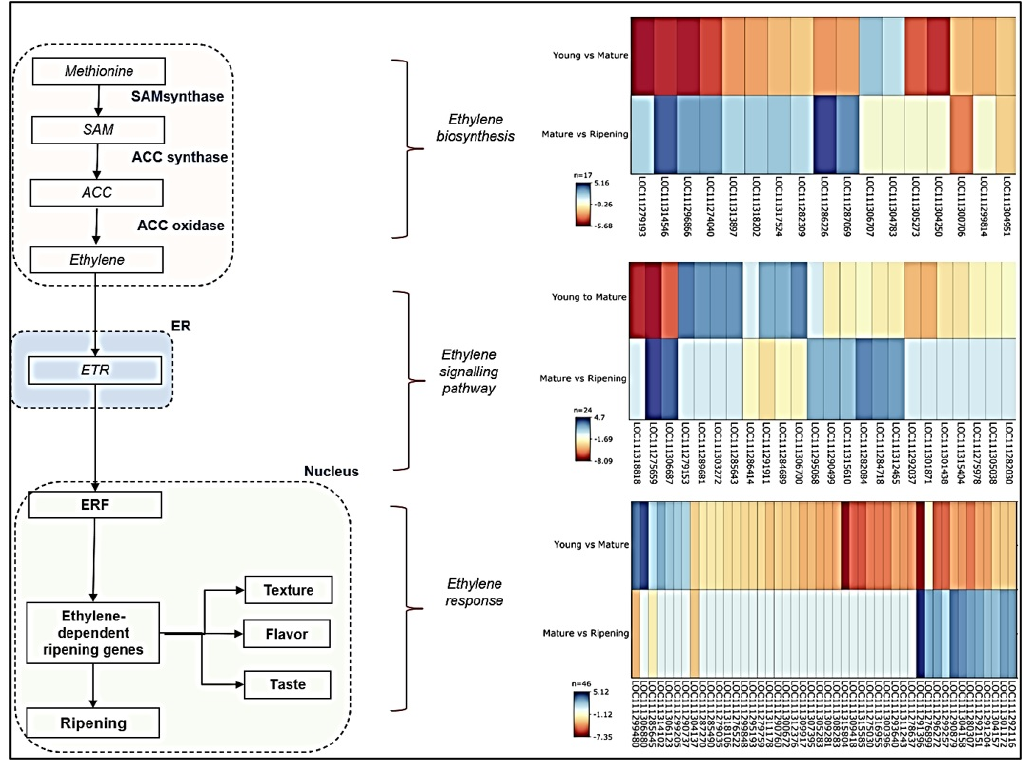
Figure 7 − Selected members of gene families involved in ethylene biosynthesis and signal transduction in durian fruit during its developmental and ripening stages. The colour scale is representing the log2 fold change